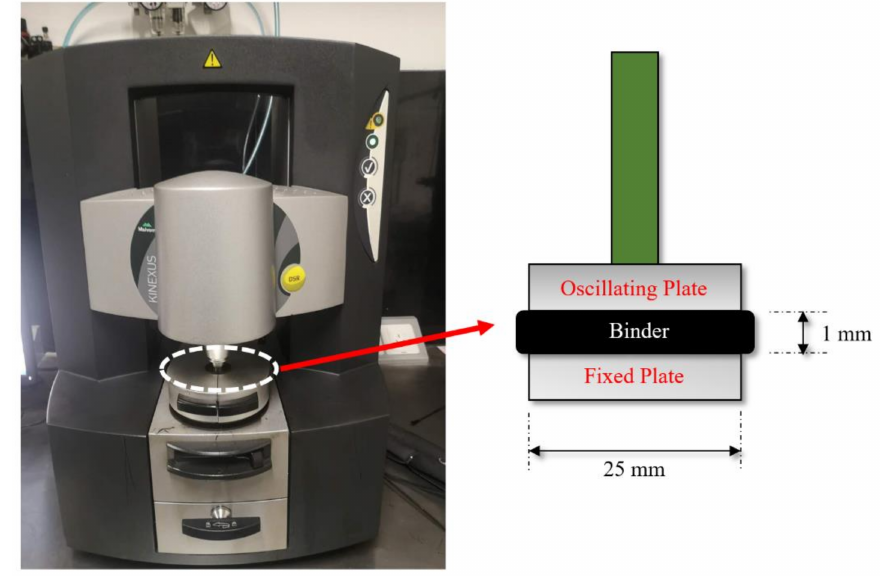
Figure 2. DSR used in the present study.